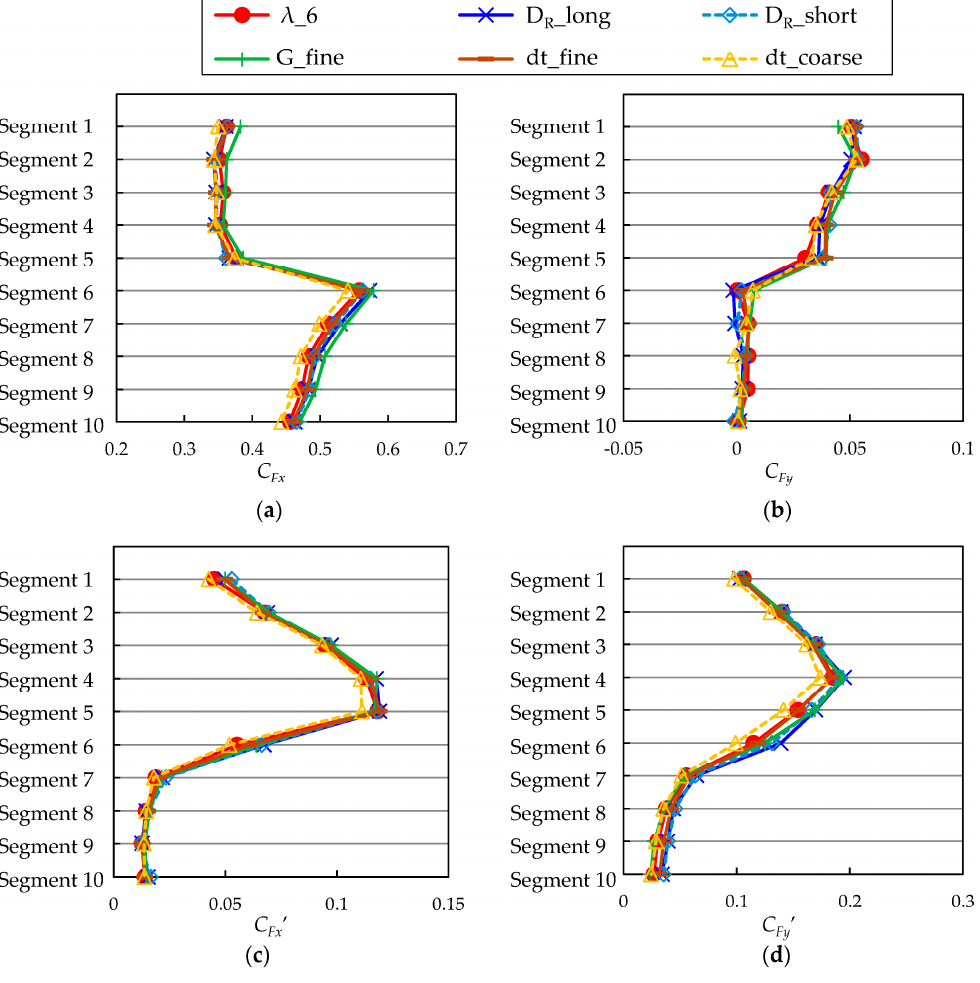
Figure 6. Sensitivity of D R , the grid resolution around the tower, and dt on distributions of the mean and fluctuating pressure coefficients on the tower surface at the mid-height of Segment 6 at λ = 6. ( a ) Mean pressure coefficient; and ( b ) fluctuating pressure coefficient.